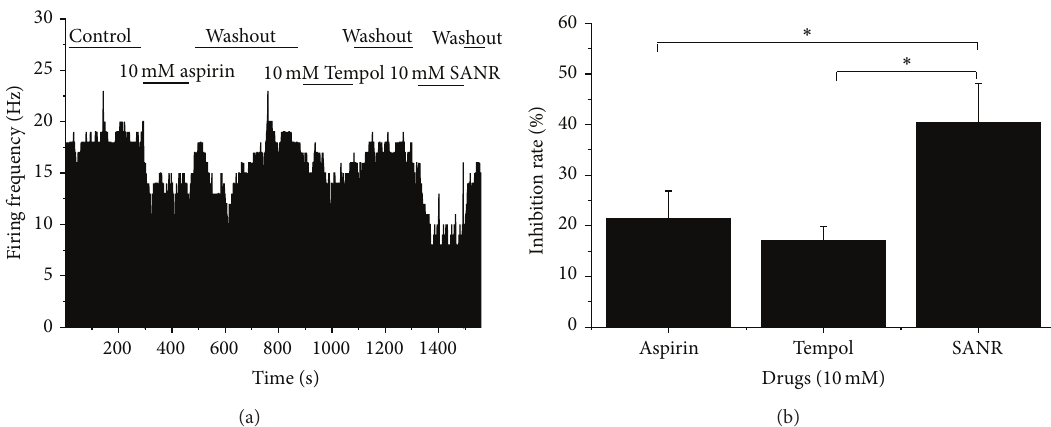
Figure 8: Comparison of the inhibitory potency of SANR (10mM) on ectopic spontaneous discharge with the same concentration of Tempol and aspirin. (a) Frequency histogram showing the inhibition of ectopic spontaneous discharge of the injured DRG neurons by SANR, Tempol, and aspirin on the same cell. (b) Quantitative analysis showing that the inhibition rate by SANR ( 𝑛 = 4 ) on spontaneous activity was much stronger than that by Tempol ( 𝑛 = 4 , 𝑃 < 0.05 ) and aspirin ( 𝑛 = 4 , 𝑃 < 0.05 ) alone. All data are expressed as mean ±